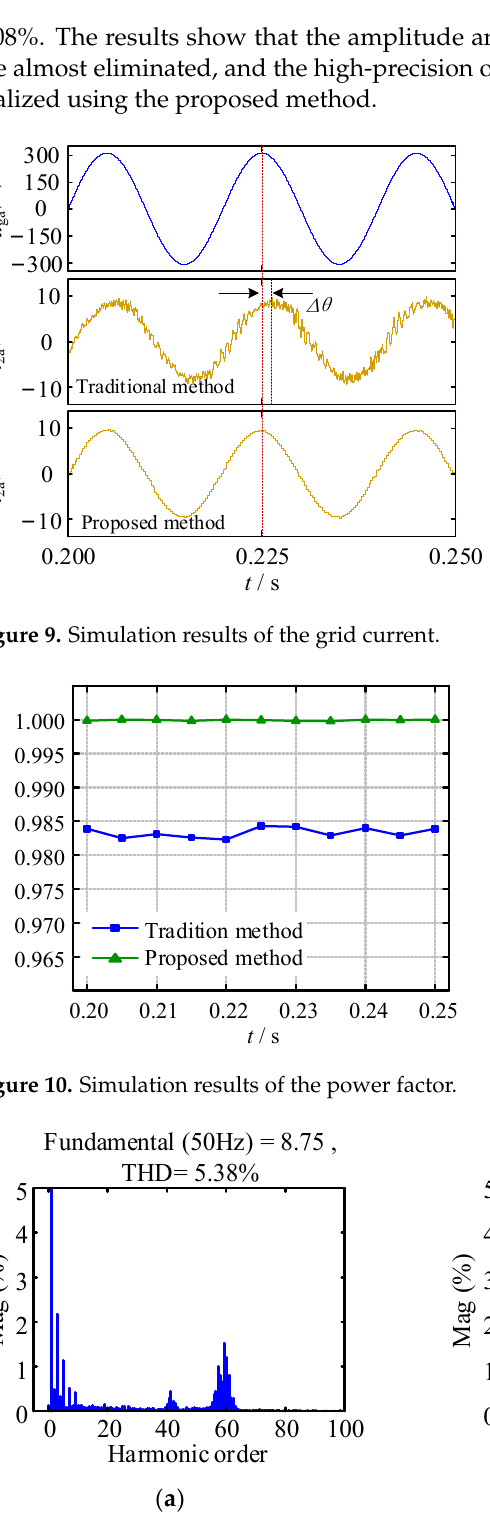
Figure 11. FFT analysis of the grid current: ( a ) Traditional method; ( b ) proposed method .